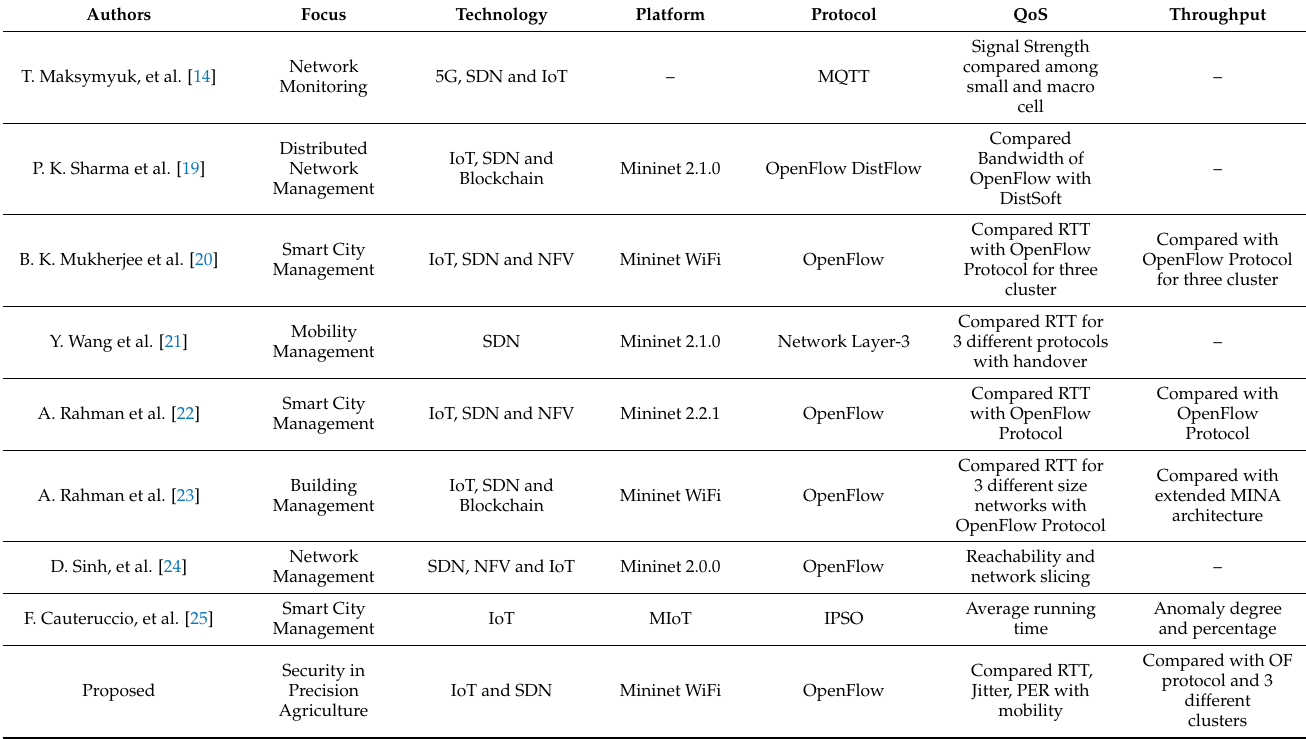
Table 1. Qualitative comparison of our proposed model along with previous